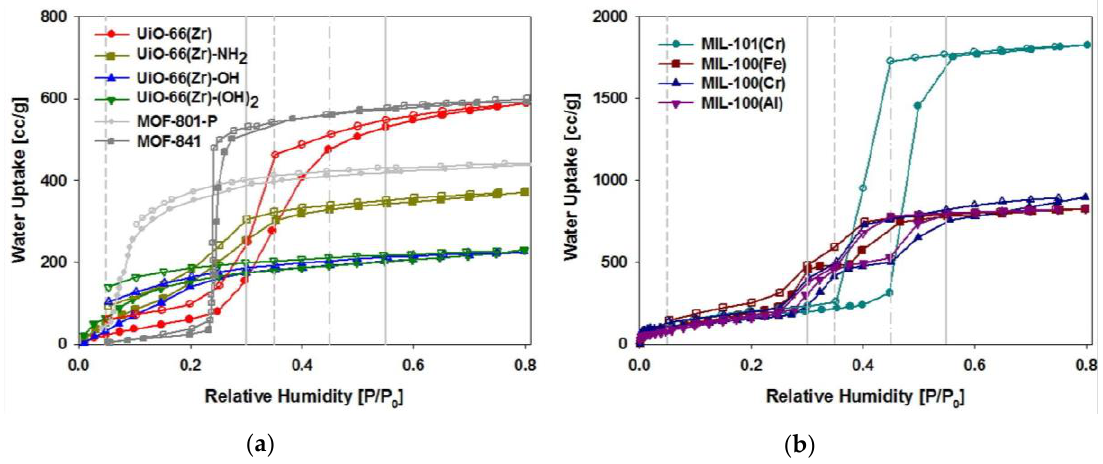
Figure 11. Water adsorption/desorption isotherms of the series of MOFs at 298 K. Reproduced with permission from [84]. Elsevier, 2016.